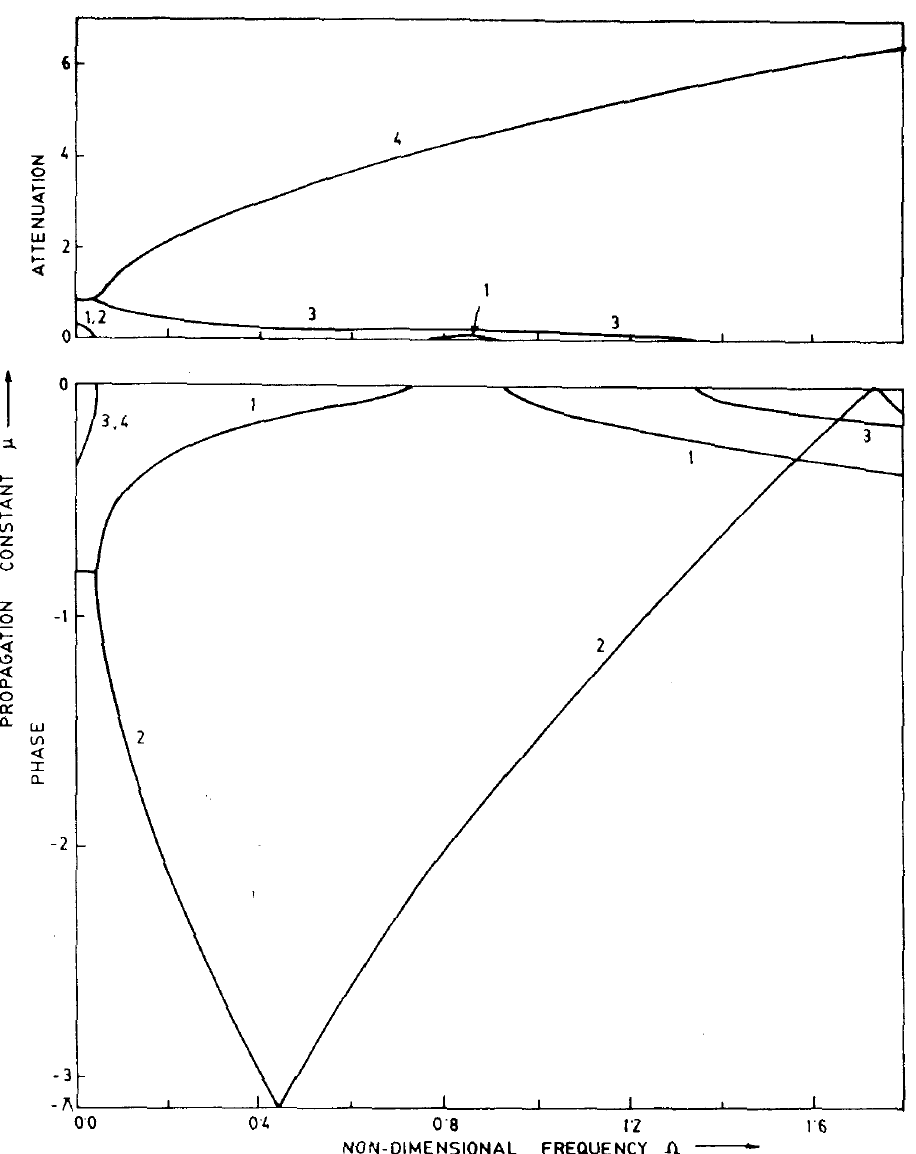
Fig. 5. Propagation constants for the cylindrical shell (Case